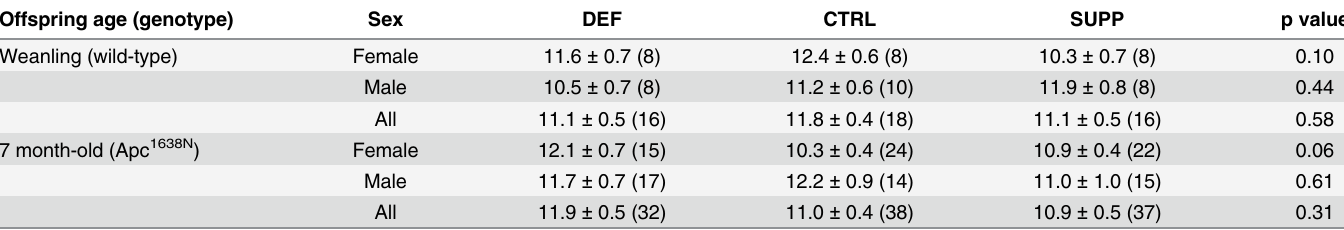
Table 3. Hepatic folate content of weanling wild-type and adult Apc 1638N offspring of fathers consuming different quantities of B vitamins. Offspring age (genotype) Weanling (wild-type)